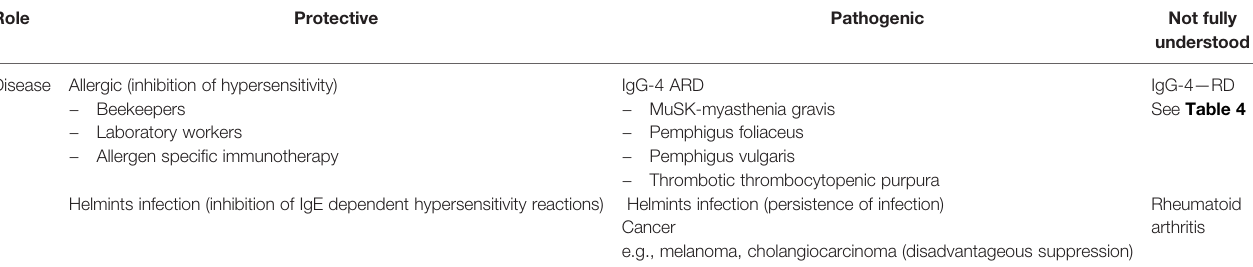
TABLE 3 | The role of IgG4 (1, 4, 10).